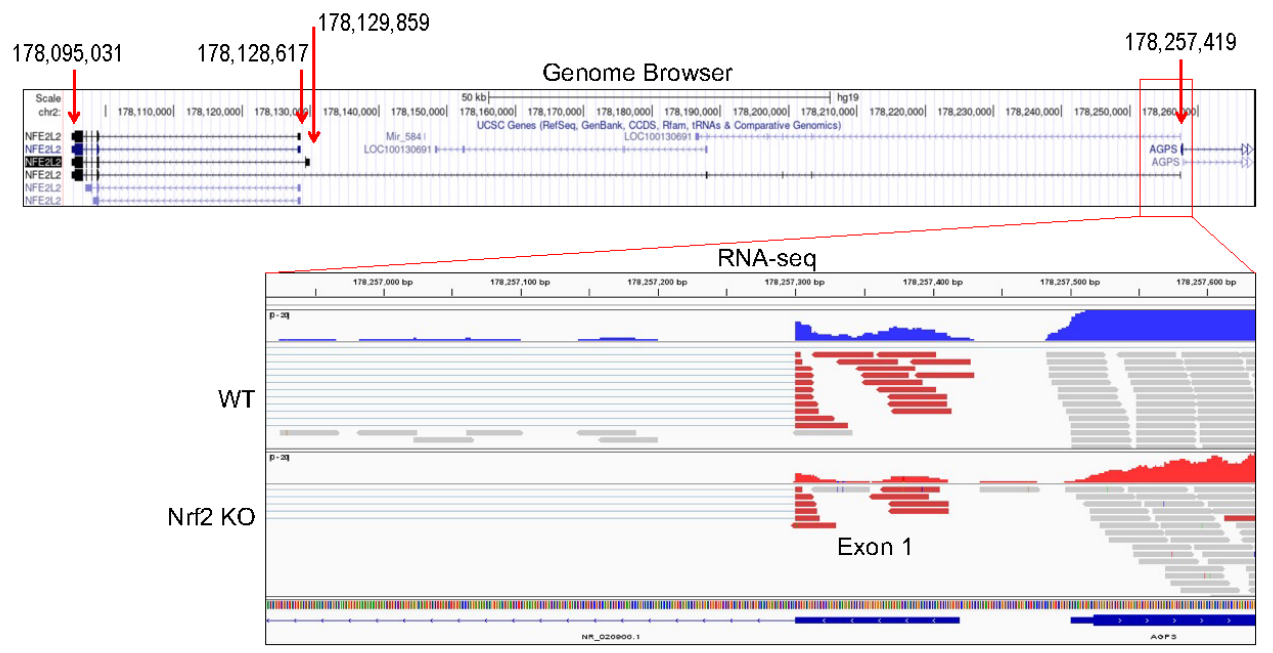
Figure 7. Genomic structure and main transcripts of the Nrf2 gene (NFE2L2). The shared promoter region of the longest transcript of Nrf2 with the AGPS gene is indicated by a red box. Bottom panel shows transcription of exon 1 of the longest Nrf2 transcript in WT and Nrf2 KO cells as determined by RNA-seq.